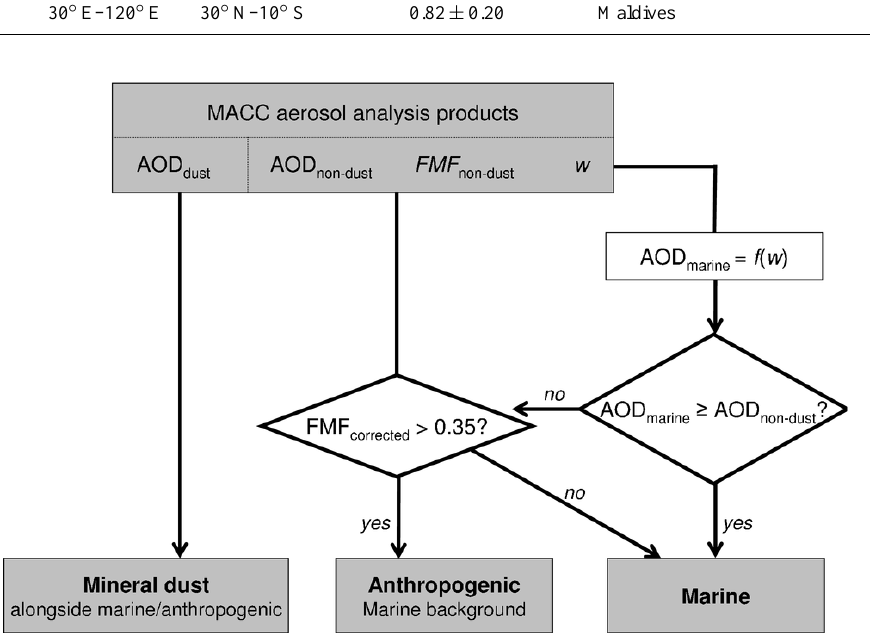
Fig. 1. Flow diagram of the algorithm used to identify mineral dust, anthropogenic, and marine aerosols from the MACC reanalysis of the aerosol optical depth (AOD) and fine-mode fraction (FMF) over the ocean. w is the near-surface windspeed simulated by the model. FMF corrected is the FMF corrected for the contribution of marine aerosols.